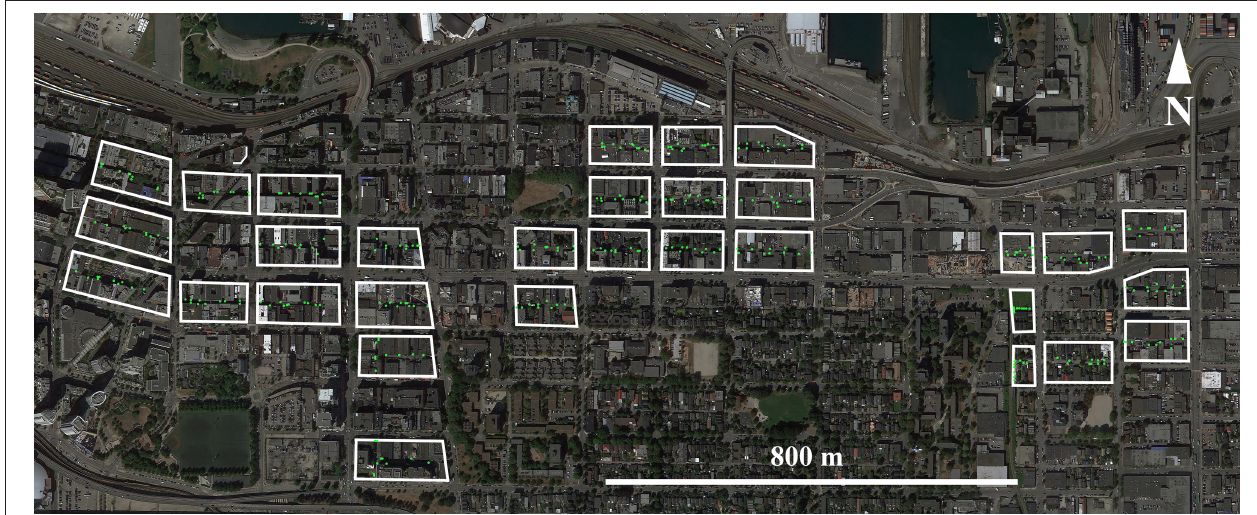
FIGURE 1 | Map of study sites in Vancouver, BC, Canada. Within each of the 31 city blocks where rats were trapped, green circles indicate the positions of the 10 traps placed in each block. Images provided through Google Earth Professional (https://www.google.com/earth/versions/#download-pro).